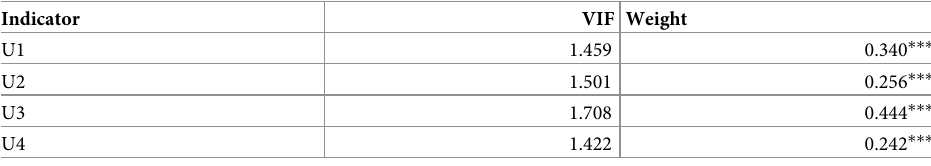
Table 8. VIF and weight of indicators of the composite